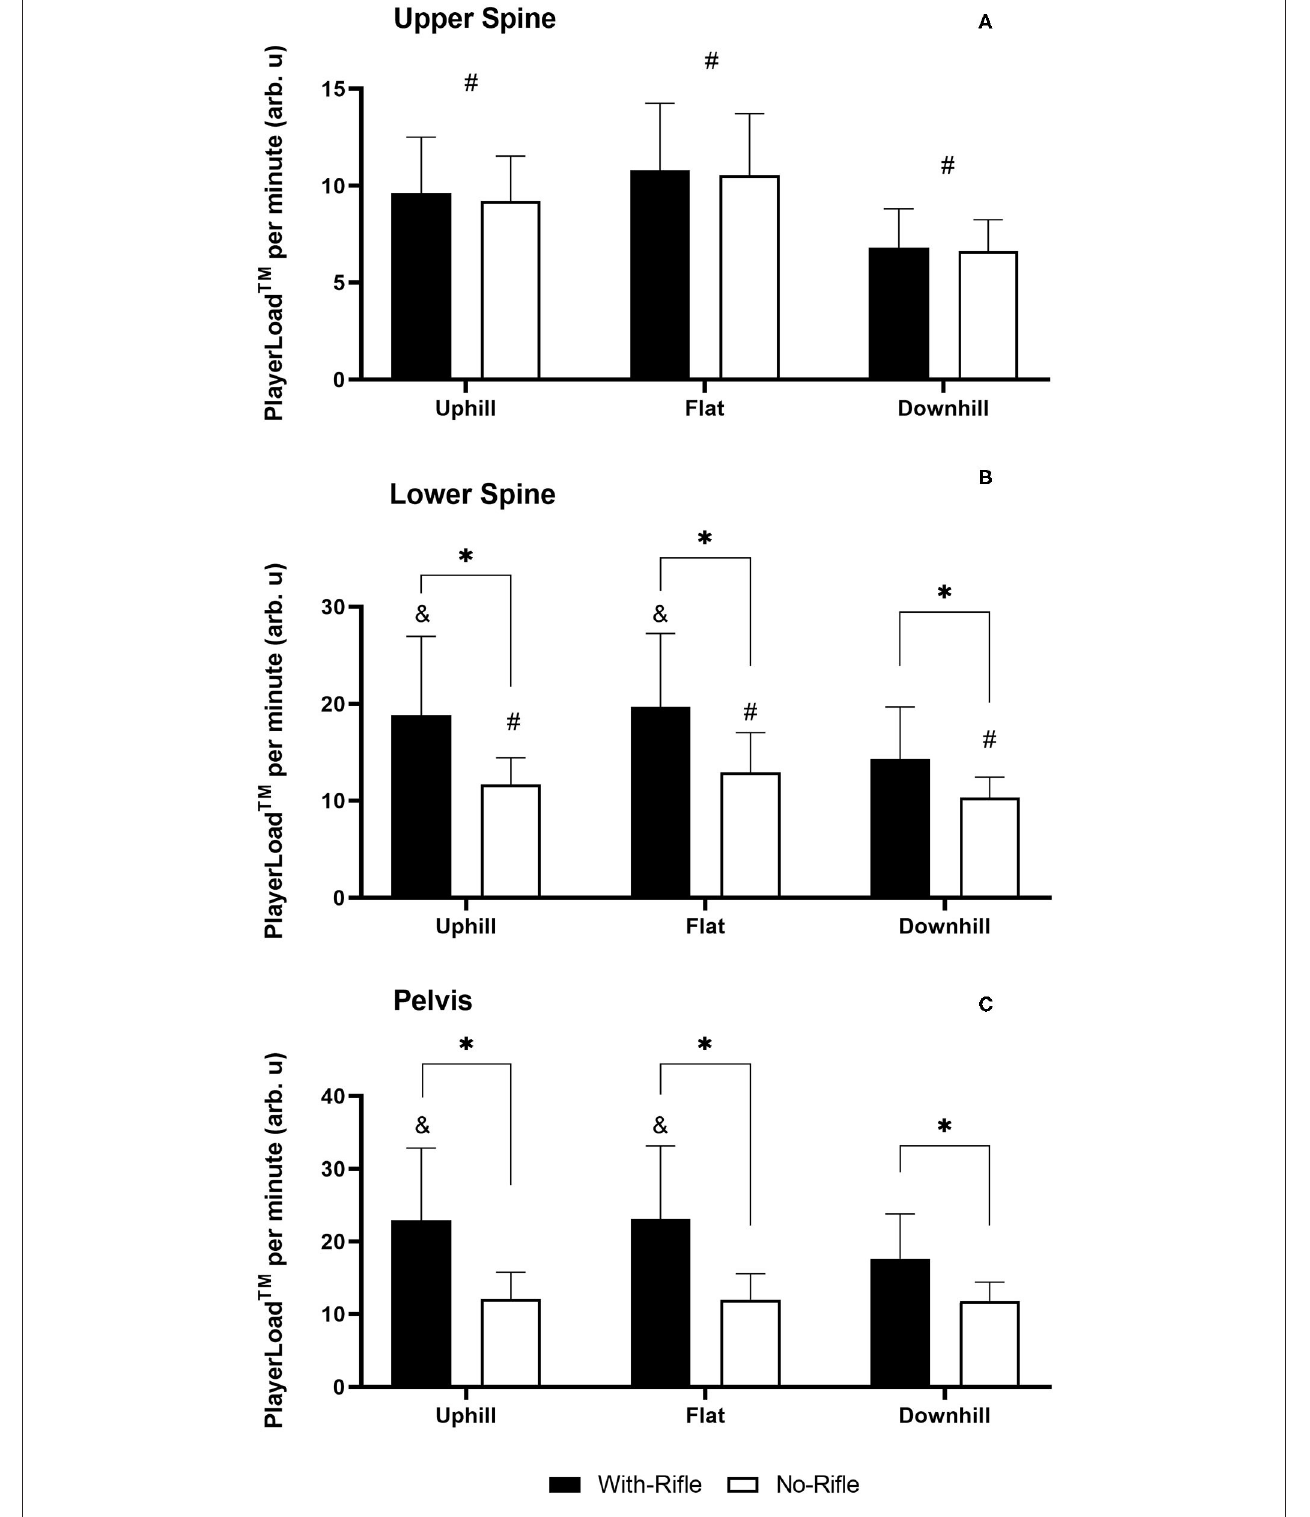
FIGURE 4 | PlayerLoad TM per minute With-Rifle and No-Rifle for all gradients for each sensor position. (A) Upper Spine; (B) Lower Spine; and (C) Pelvis. Mean ± standard deviation. *different to With-Rifle within condition ( p < 0.001); # different to all other gradients ( p < 0.001); & different to Downhill within condition ( p < 0.001).